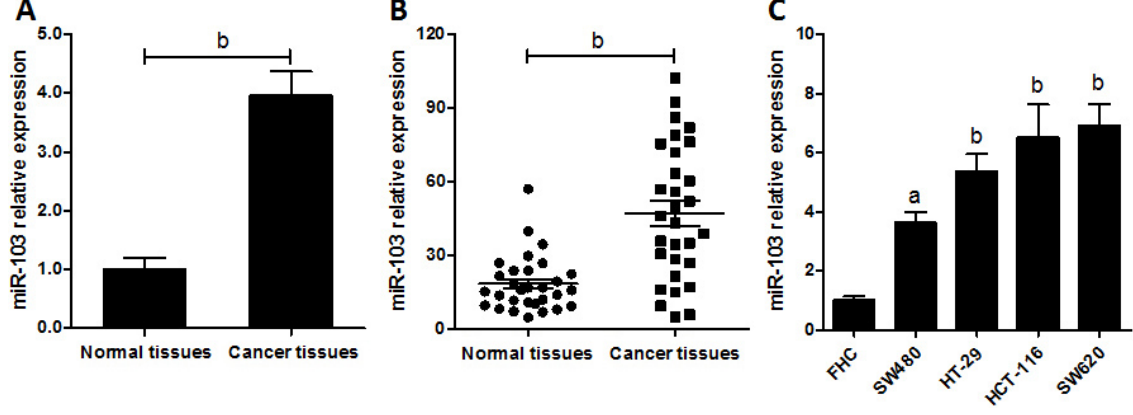
colorectal cancer tissues and the matched normal control tissues, and miRNA expression profiles were determined by miRNA microarray. miR-103 expression was normalized to control of random sequences of a similar size. One representative of two experiments is shown; ( B ) The expression level of mature miR-103 in colorectal cancer tissues and their matched normal tissues were determined by real-time polymerase chain reaction (PCR); and ( C ) The expression level of miR-103 in four colorectal cancer cell lines and normal colonic cells were checked by real-time PCR. Data are representative of three